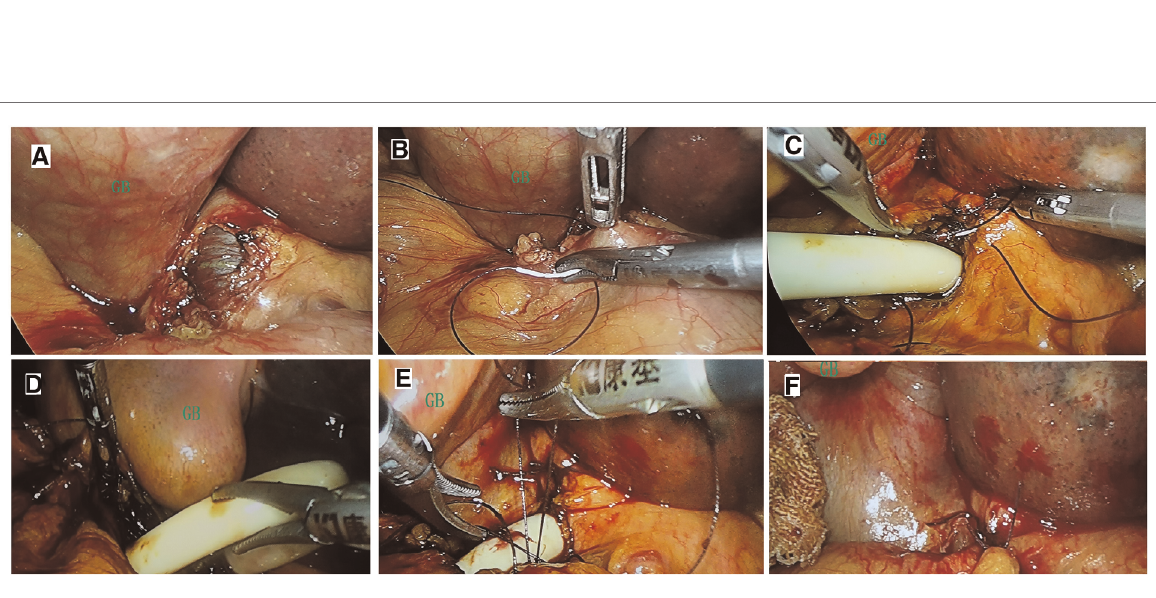
FIGURE 2 Surgical procedure of laparoscopic bridge choledochoduodenostomy. After the exploration of the abdominal cavity, the common bile duct was exposed fi rst ( A ). An ostomy was made in the duodenum below the common bile duct, and a presutured double-layer suture was performed around ( B ). The trimmed T-tube was placed in the common bile duct and fi xed ( C ). After the distal end of the T-tube was placed in duodenum through the ostomy ( D ), the presutured double-layer suture line was tightened ( E ). Then the adjacent greater omentum tissue was pulled to cover the T-tube ( F ). GB, gall